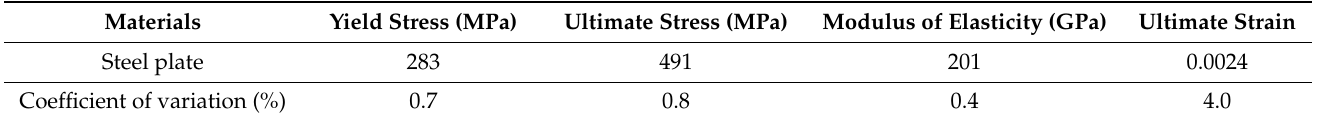
Figure 2. Geometry of the steel plates. Table 1. Properties of steel plates with 6 mm thickness.